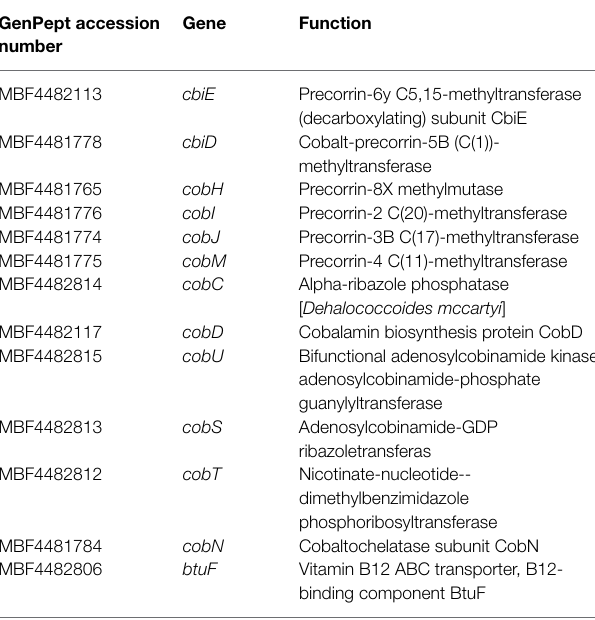
TABLE 5 | Genes encoding hydrogenases in D. mccartyi from TCE/Cr(VI)